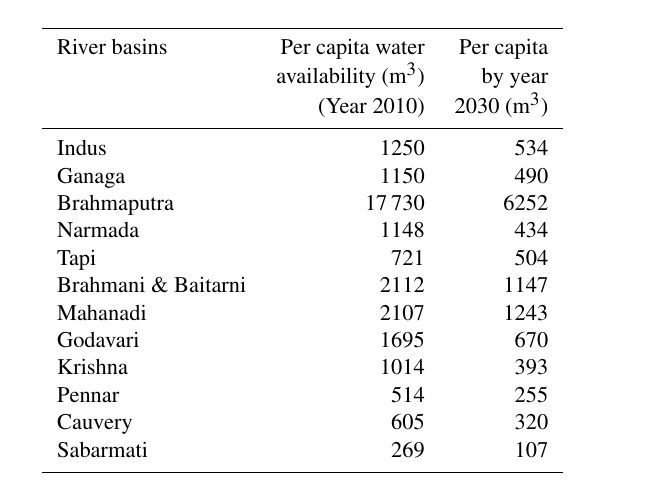
Table 1. Water availability in the major river basins.